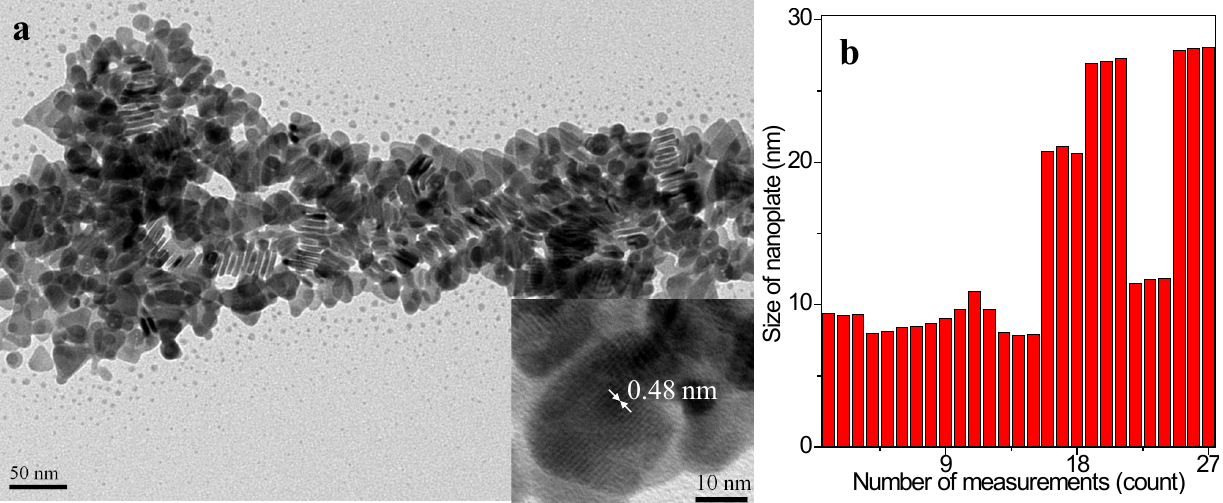
Figure 2. Triangular silver nanoplate solution ( a ) TEM image; the inset picture shows the lattice spacing of triangular nanoplates and ( b ) size distribution from dynamic light scattering (DLS)